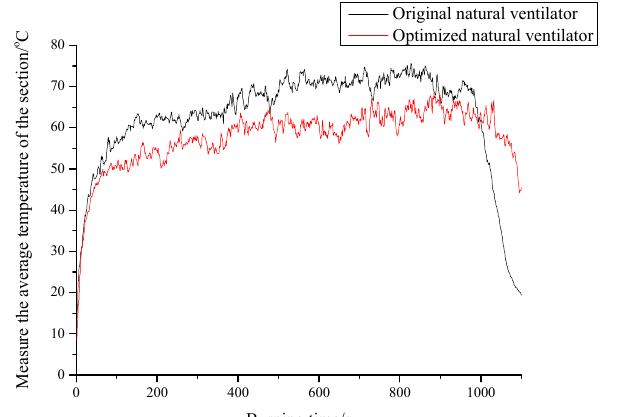
Figure 23. Temperature change of ventilator before and after optimization in fire environment (fire scale: 20 × 20 × 4 cm).